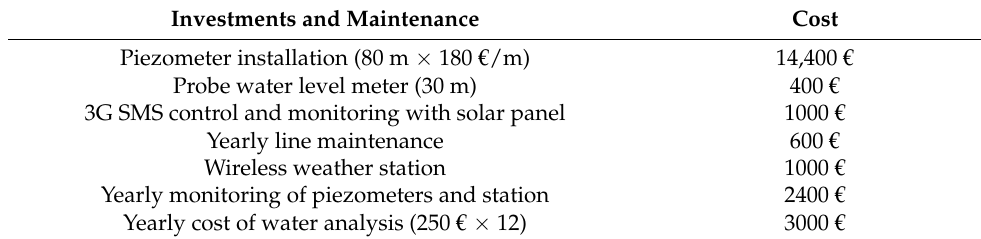
Table 2. Investments and maintenance